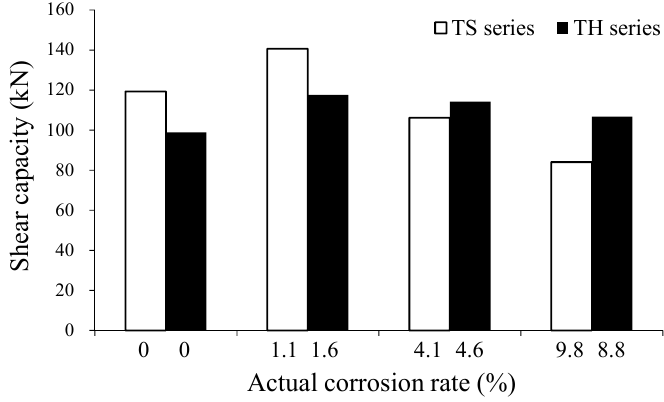
Figure 10. Effects of corrosion rates on shear capacities of test specimens.